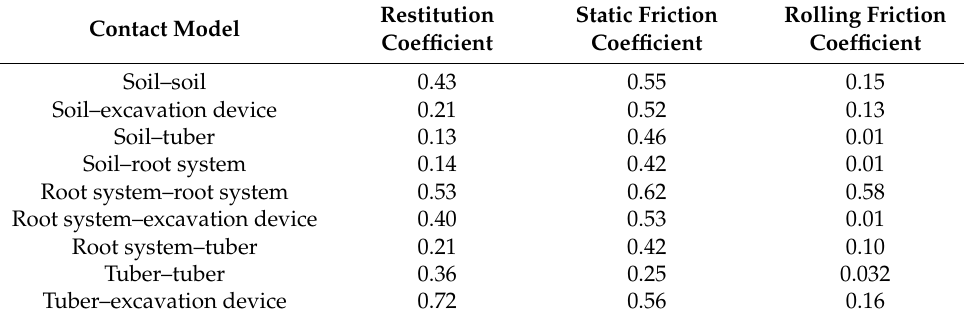
Table 2. Discrete element contact parameters.